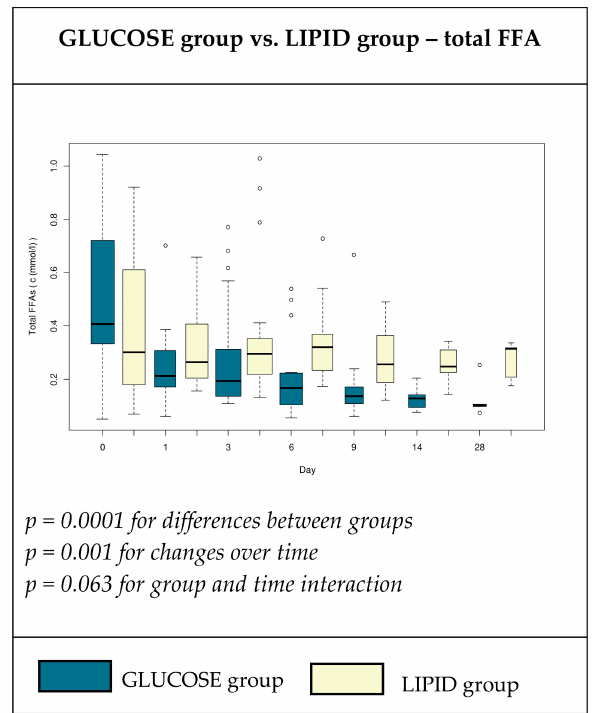
Figure 1. Plasma concentrations (mmol · L − 1 ) of total free fatty acids (FFAs) in patients receiving high glucose; lipid-free (glucose group); or low glucose, high lipid (lipid group) total parenteral nutrition (TPN) admixtures.